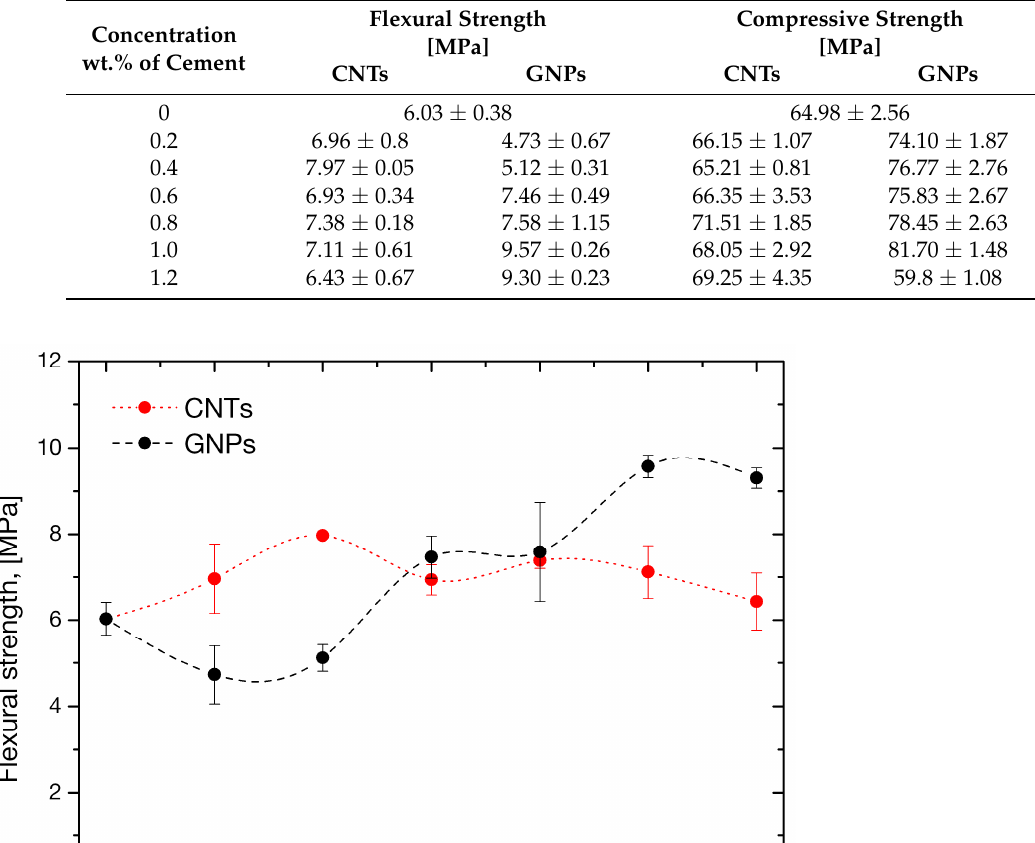
Figure 7. Compressive strength variation in mortars as function of CNT and GNP concentration. 3.2. Fracture Behavior with in Situ AE Monitoring Average values and standard deviations of fracture energy, GF, calculated as per 2.2.3, are plotted in Figure 8 and tabulated in Table 5, for mortars with different concen-